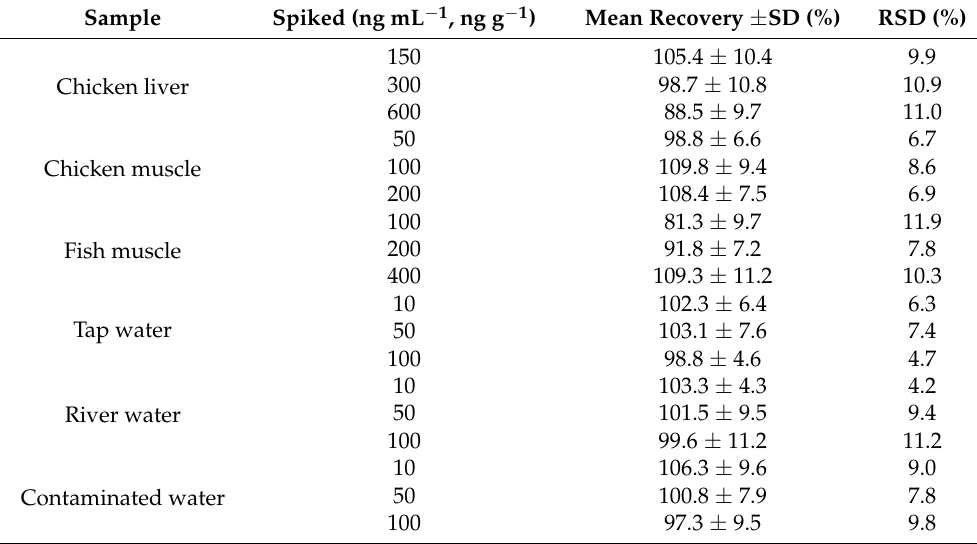
Table 3. Accuracy and precision of DOX in spiked samples by QD-cFIA (n = 5). Sample